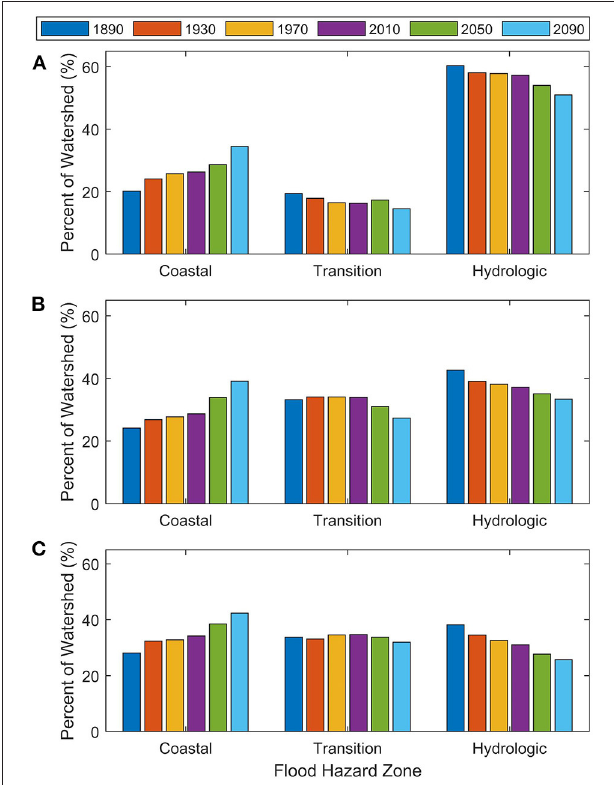
FIGURE 7 | Percent of the watershed made up of each flood hazard zone for the Lake Maurepas watershed under different flood magnitudes: (A) low, (B) medium, and (C) high flood events. Each bar color represents a different era